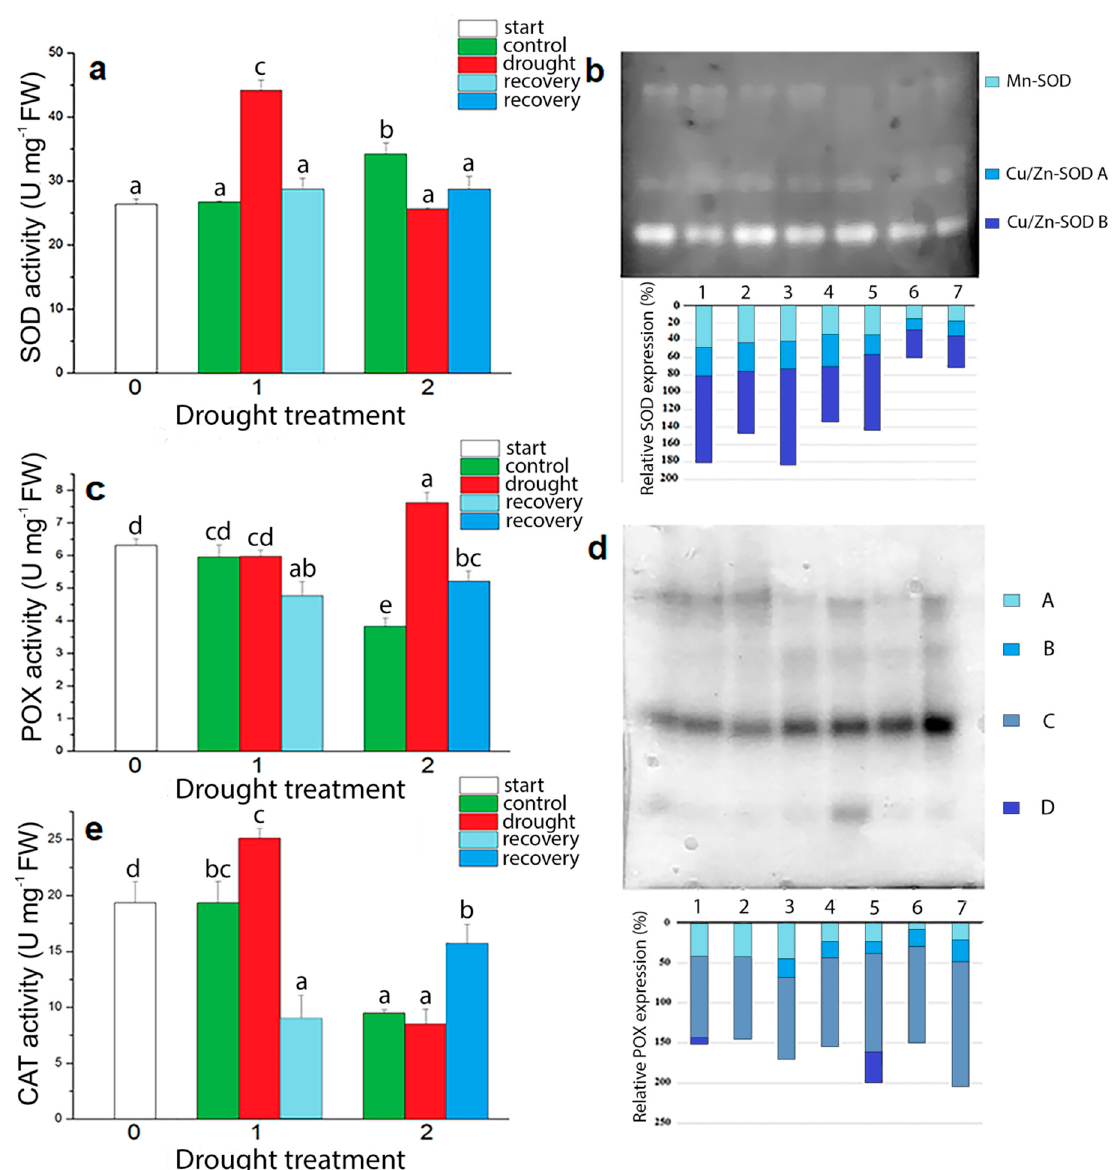
Figure 9. ( a ) superoxide dismutase (SOD) activity; ( b ) SOD isoforms and their relative expression (%); ( c ) peroxidase (POX) activity; and ( d ) POX isoforms and their relative expression (%) and catalase (CAT) activity ( e ) in drought-stressed I. walleriana grown ex vitro. ( a , c , e )—the “start point”, 15% and 5% of soil moisture content—0, 1 and 2, respectively; ( d , e )—the “start point” (1), 15% of soil moisture content—control (2), drought (3), recovery (4) and 5% of soil moisture content—control (5), drought (6) and recovery (7). Results represent mean ± SE ( n = 8). The letters indicate statistically significant differences based on the Fischer LSD test ( p ≤ 0.05).